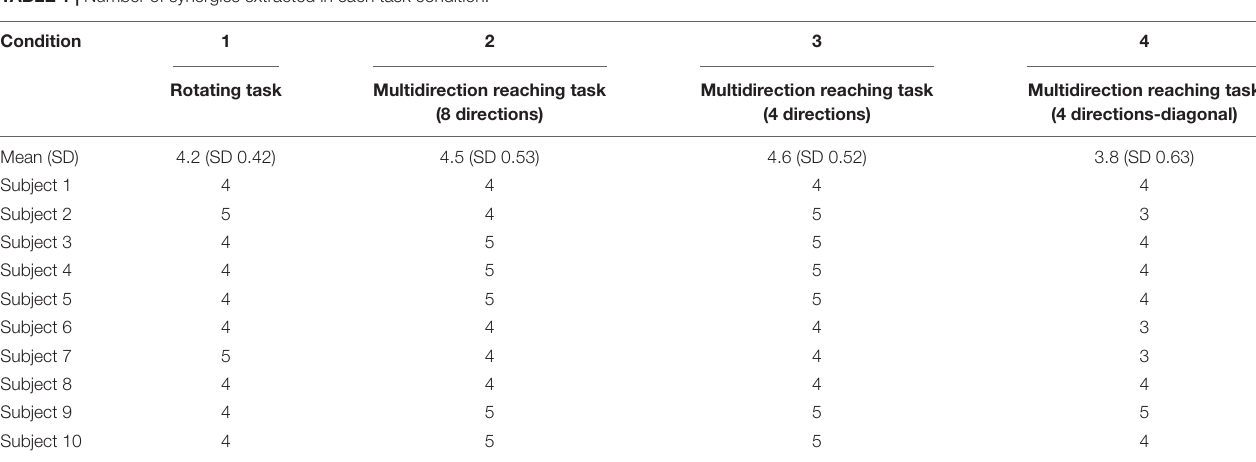
FIGURE 6 | Synergy set extracted in all conditions (condition 1—the rotating task, condition 2—the multidirection reaching task with 8 targets, condition 3—the multidirection reaching task with 4 targets, and condition 4—the multidirection reaching task with 4 targets in diagonal directions) from a representative subject (subject 8). TABLE 1 | Number of synergies extracted in each task